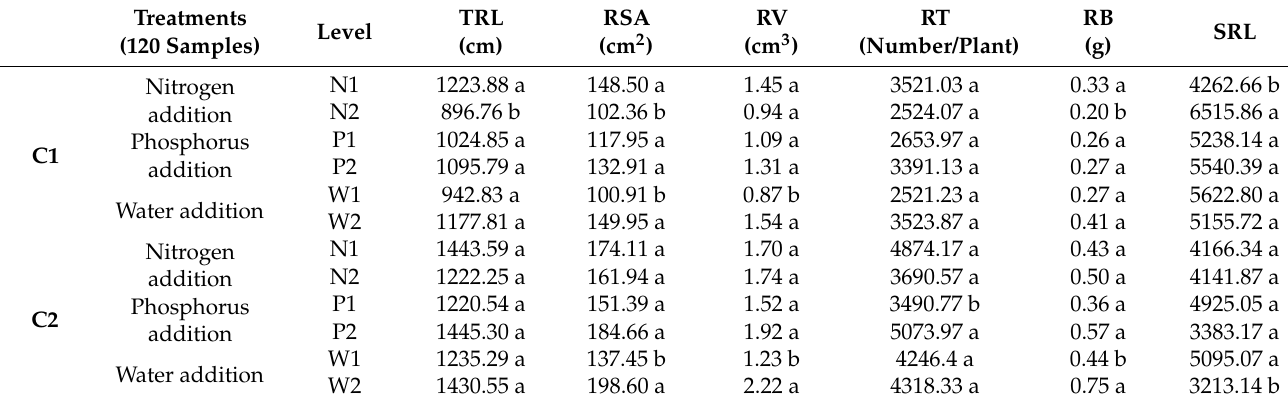
Table 5. The one-way analysis of variance (ANOVA) of the effects of nitrogen addition, phosphorus addition and water addition on root biomass, total root length, root surface area, root volume, root tips and specific root length under each level of fragment size for Stipa breviflora .